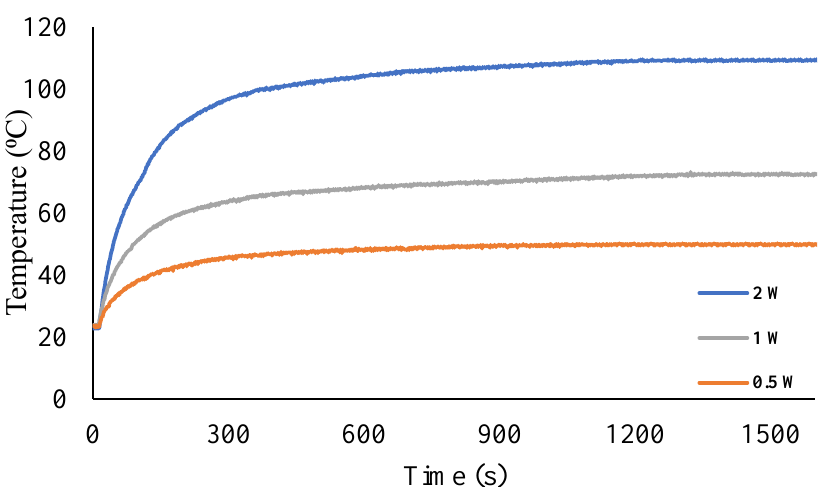
Figure 8. Temperature distribution for the heat sink for 0.5, 1, and 2 W. To investigate the effect of Arachidic acid and its mixtures on the cooling of the heat sink, a set of experiments was performed. By adding the Arachidic acid (being considered as a PCM), the stead-state temperatures for 0.5, 1 and 2 W were 41.75 ◦ C, 65 ◦ C and 104.5 ◦ C, respectively. As one can see from Figure 9, the PCM does not melt at 0.5 and 1 W, because the steady-state temperature for those powers is lower than the melting temperature of Arachidic acid. It took 500 s and 1000 s to reach the steady-state temperature for the cases of 0.5 W and 1 W, respectively. Meanwhile, in the case of 2 W, the PCM melted completely after about 1180 s, delaying the peak temperature of the sink by 300 s. It can be seen that the stead-state temperatures of the three cases, even without the melting of PCM, were decreased compared to that without PCM.